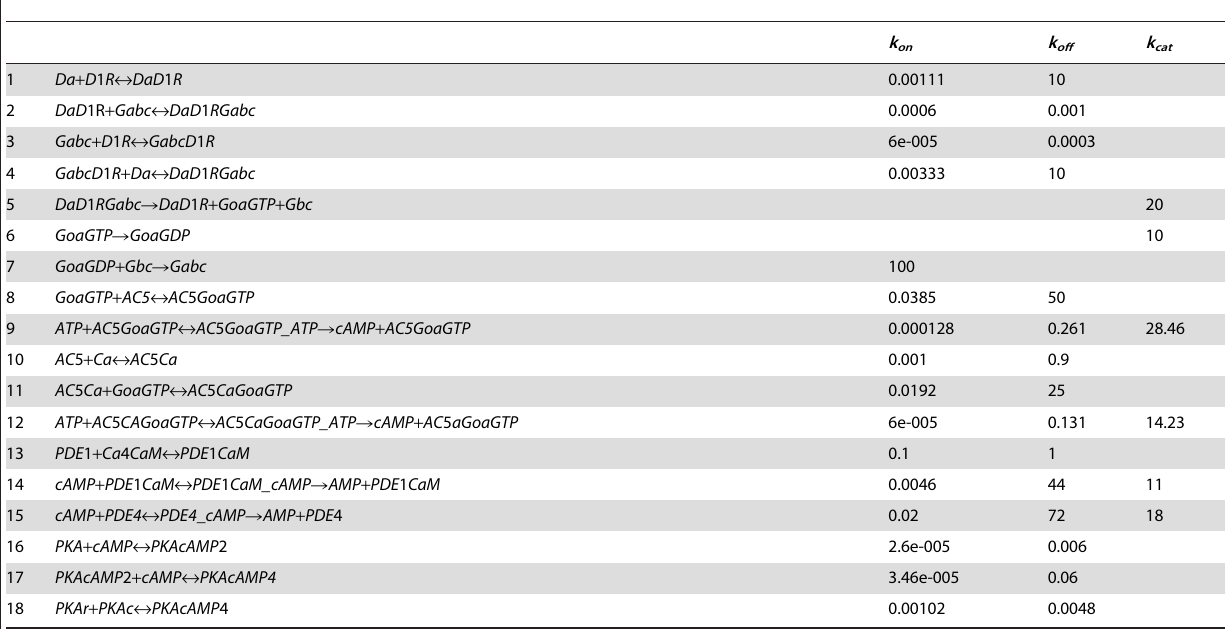
Table 1. Reactions in the cAMP pathway.